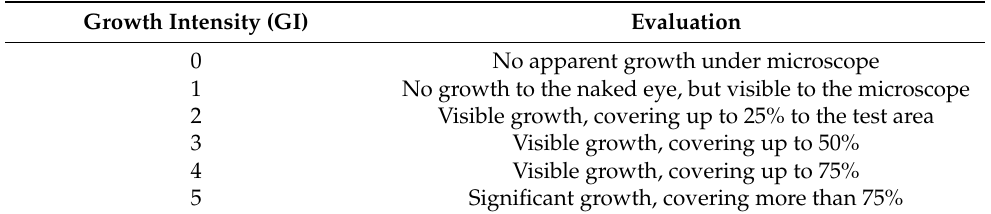
Table 1. Evaluation of growth intensity according to ISO 846 [22]. Growth Intensity (GI) Evaluation 0 No apparent growth under microscope No growth to the naked eye, but visible to the microscope Visible growth, covering up to 25% to the test area Visible growth, covering up to 50% 4 Visible growth, covering up to 75%